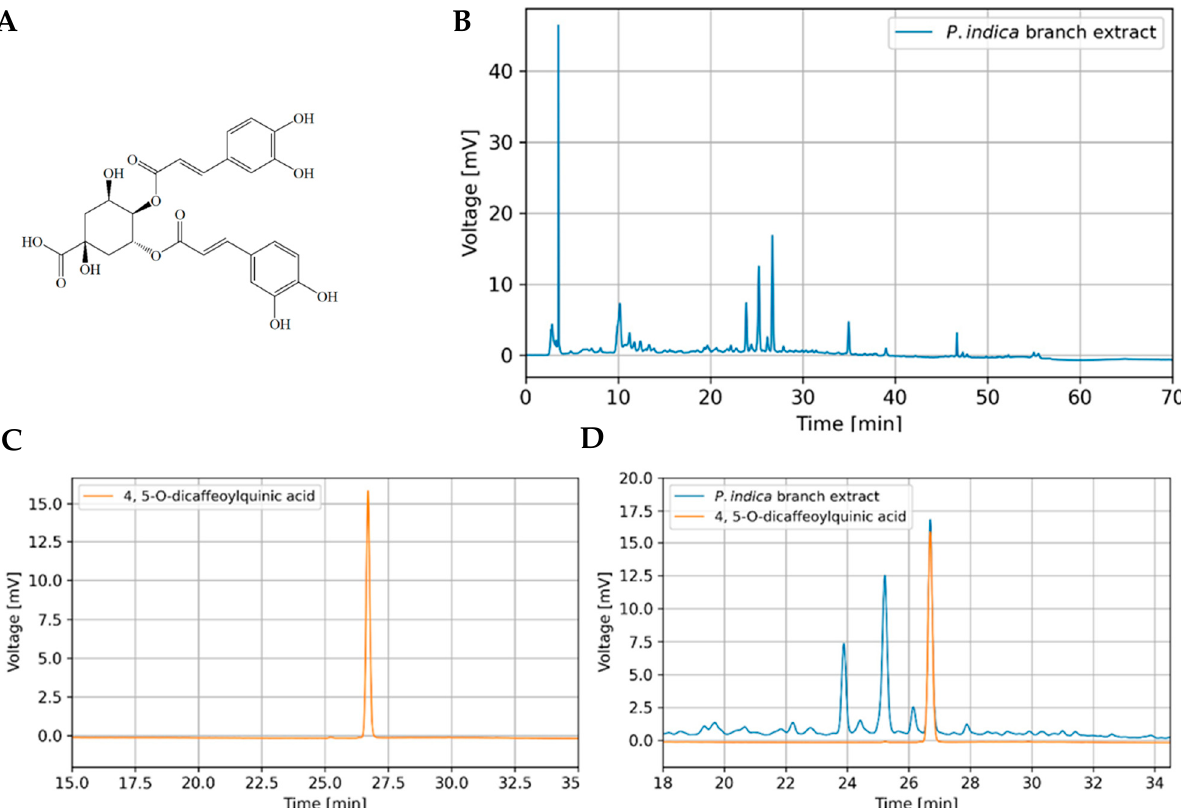
Figure 1. ( A ) Chemical structure of 4,5- O -dicaffeoylquinic acid ( B ) HPLC chromatograms of P. indica branch extract ( C ) 4,5- O -dicaffeoylquinic acid standard and ( D ) overlaid HPLC chromatogram of P. indica branch extract and 4,5- O -dicaffeoylquinic acid standard.